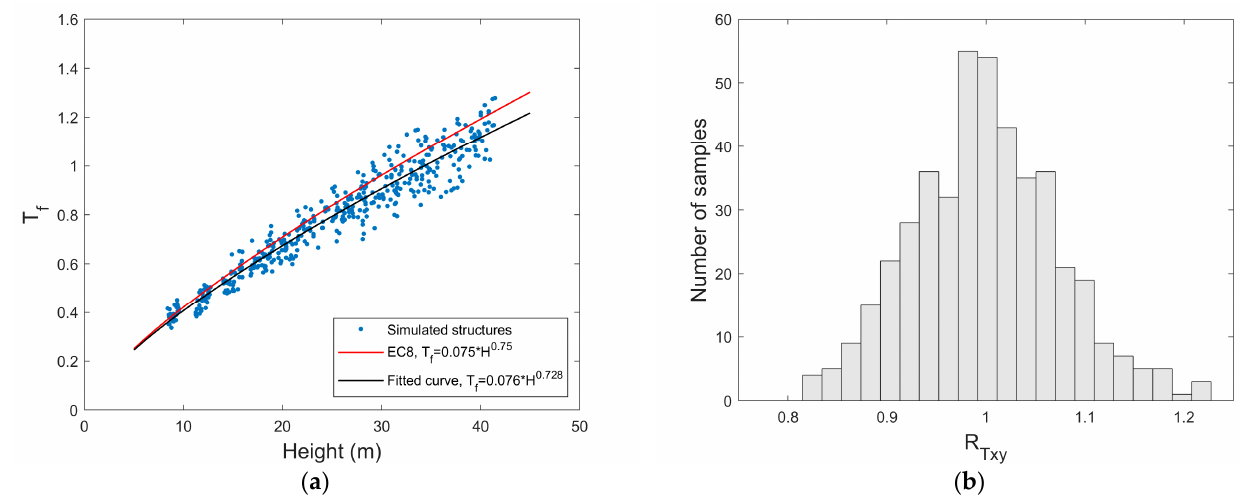
Figure 2. ( a ) Fundamental period of 444 building models generated with KaIROS software; ( b ) dissimilarity between the horizontal stiffness of the 3D models.